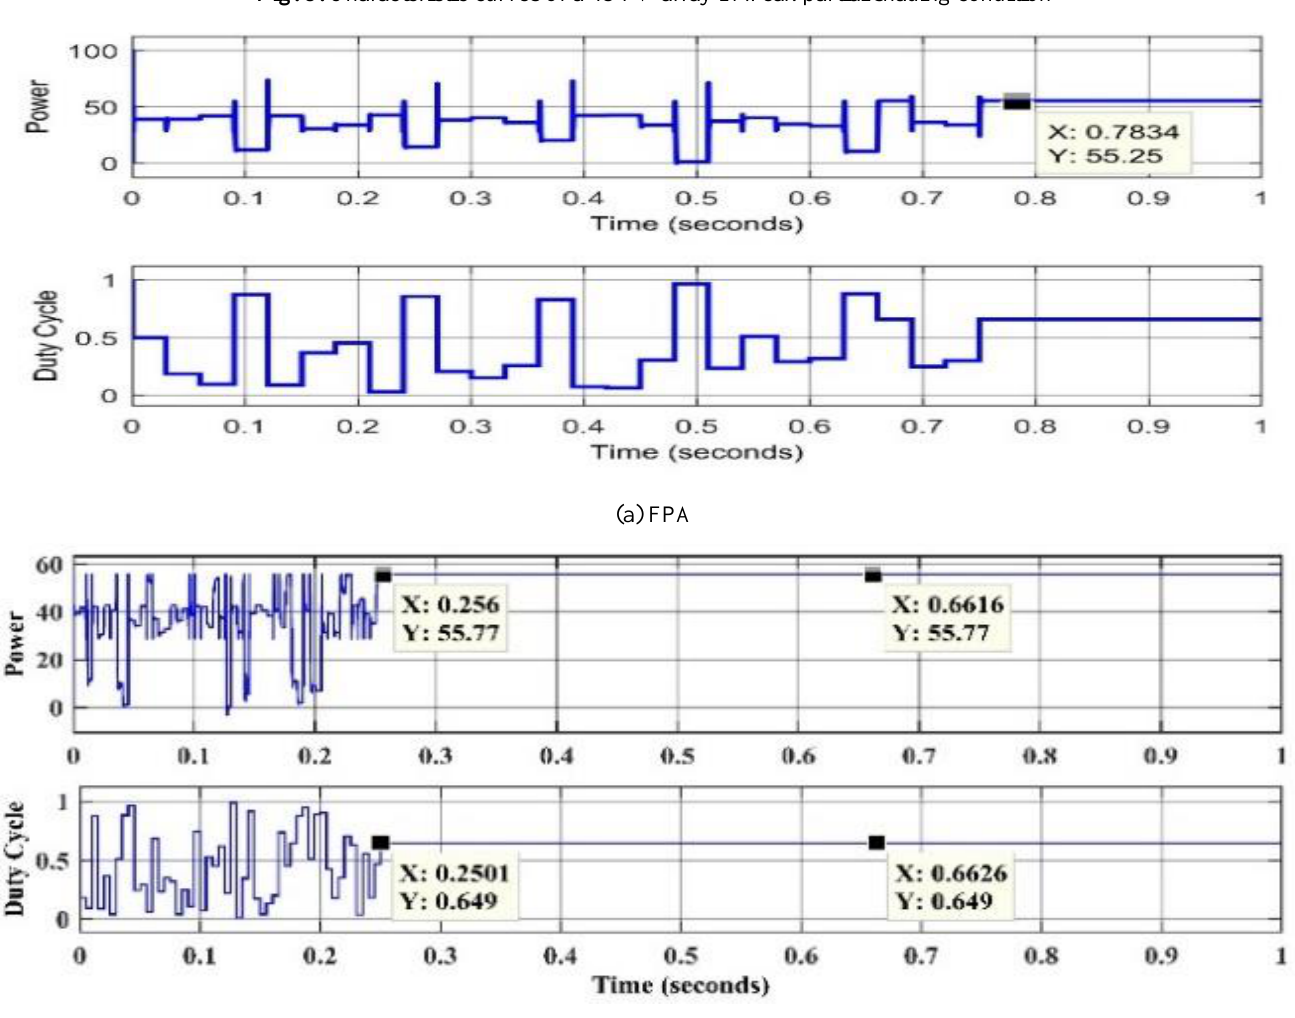
Fig. 8. Characteristic curves of a 4S PV array in weak partial shading